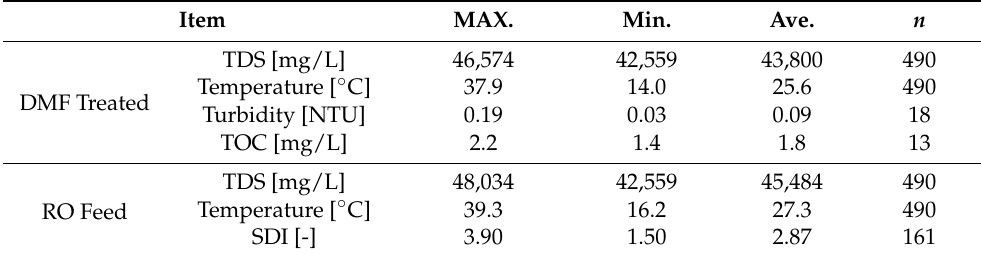
Table 4. Common quality of DMF treated water and RO feed.